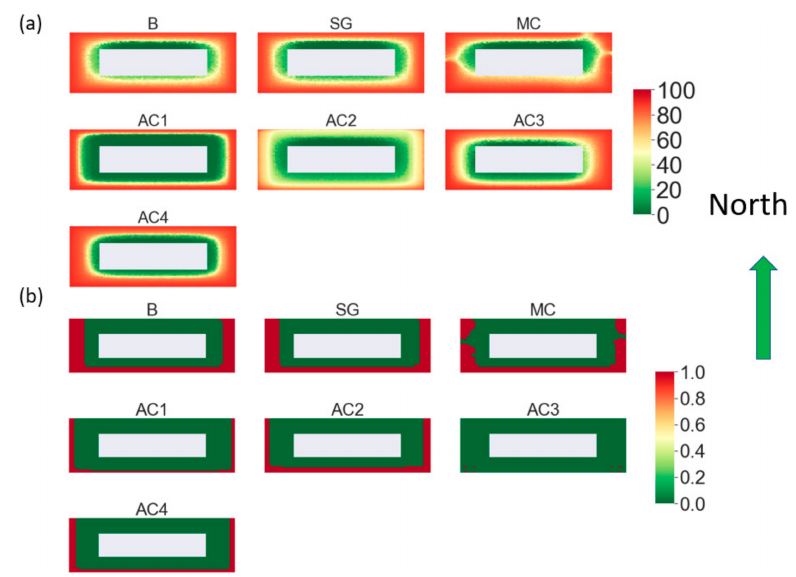
Figure 6. Daylight grid heat map for Chicago: ( a ) daylight autonomy, ( b ) annual sunlight exposure.